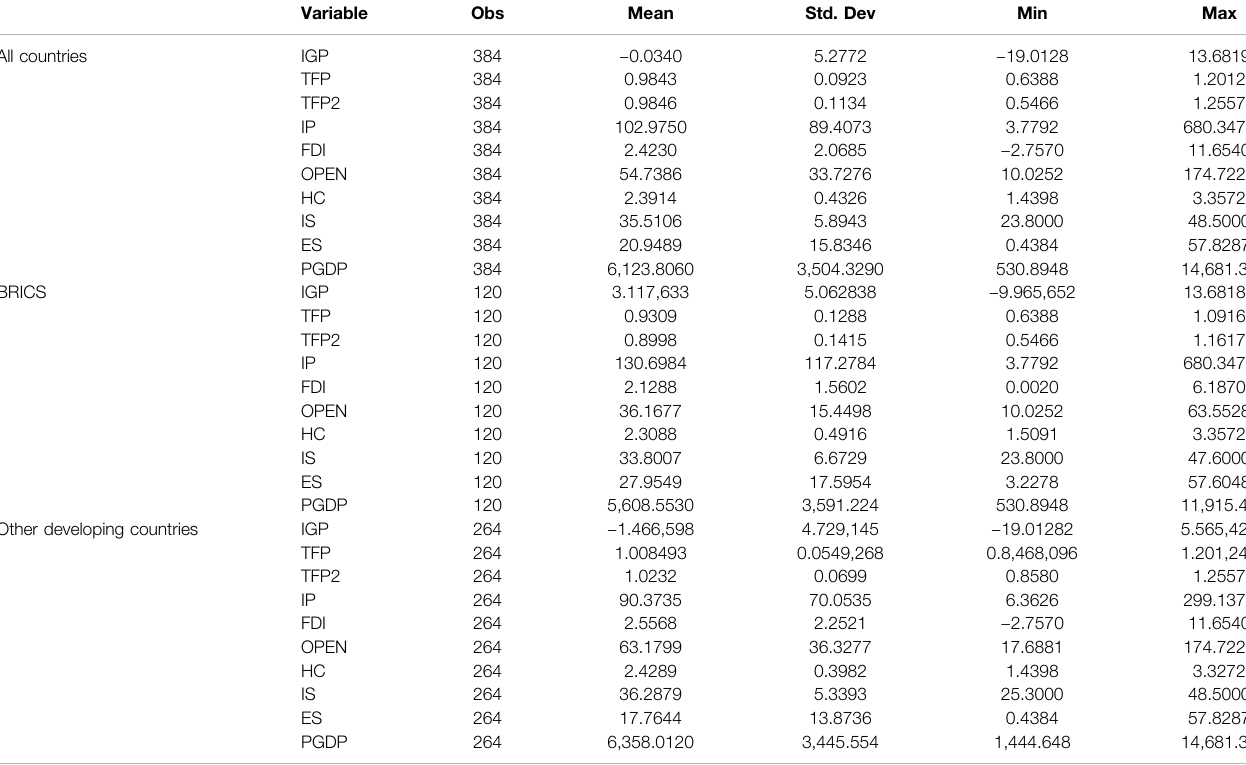
TABLE 1 | Descriptive statistics.